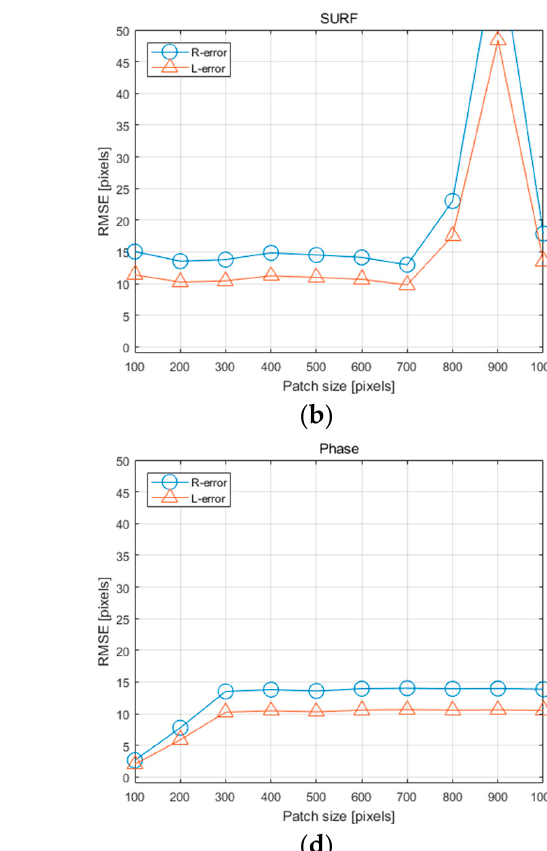
Figure 16. Reprojection errors (across-track Kompsat-3A original—before adjustment): ( a ) HARRIS– FREAK ( b ) SURF, ( c ) MI, and ( d ) PC.